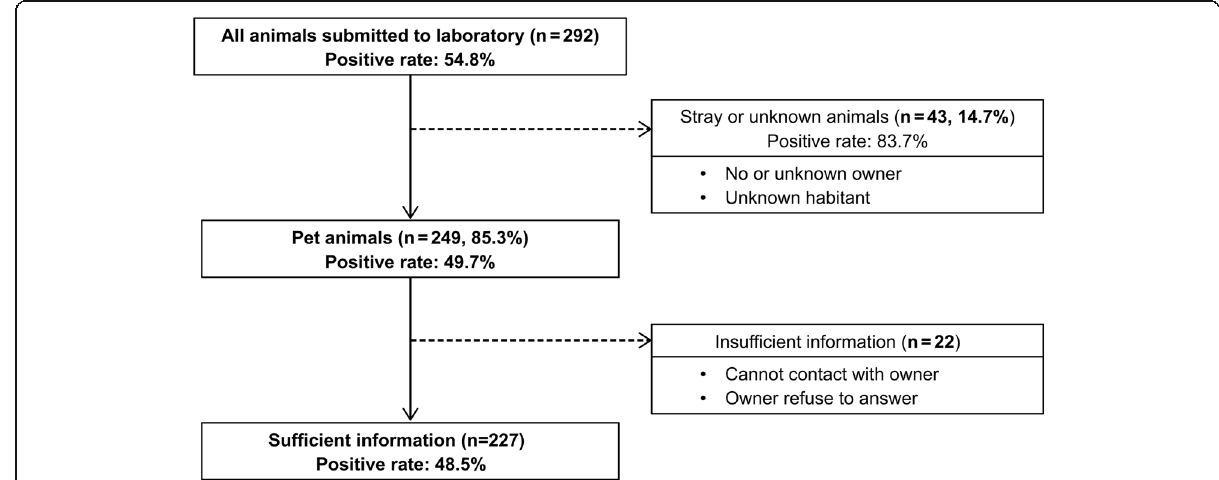
Fig. 2 Number of animal samples submitted to Regional Animal Laboratory and the positive rate